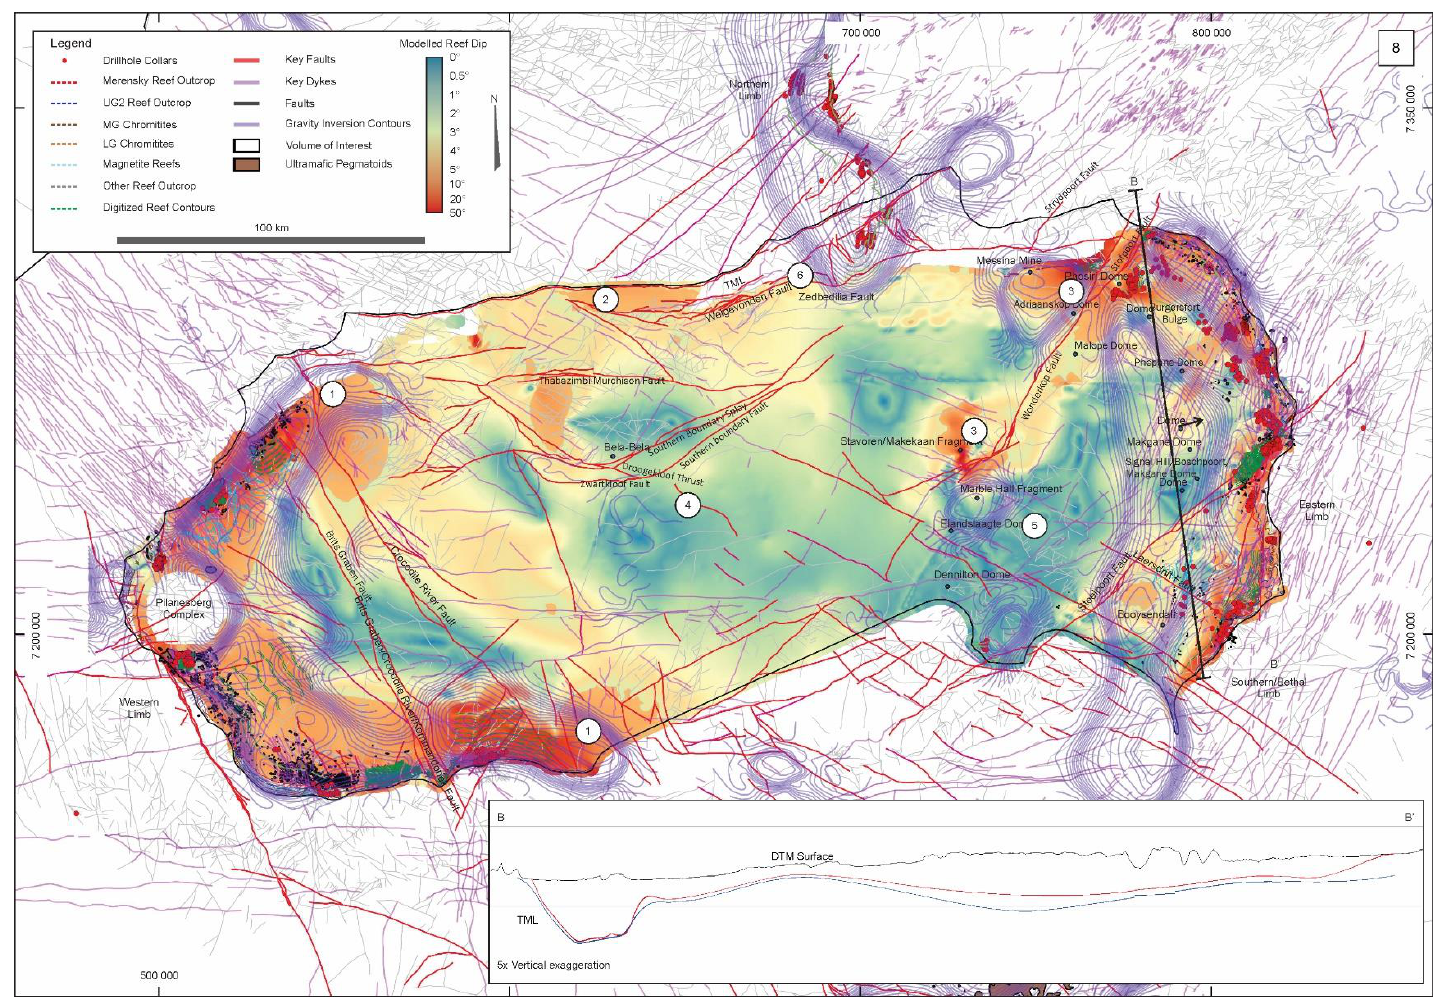
Figure 8. Modelled Merensky Reef surface dips. Position of section line B–B’ indicated on map. Section line highlights high dip angles towards the Stofpoort Fault zone (Point 3). Numbered points of interest are discussed in the text.